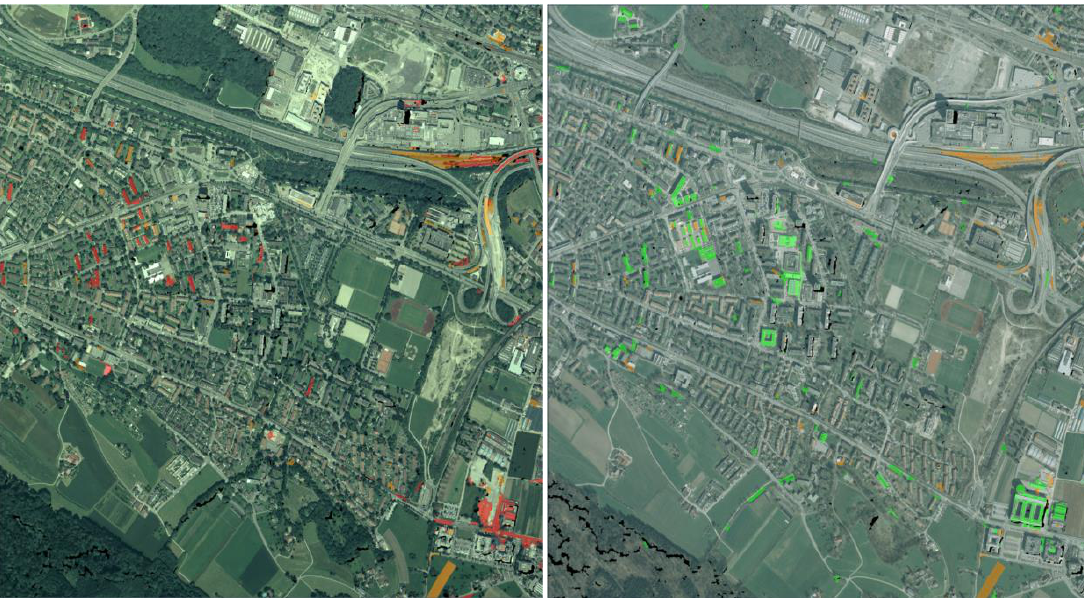
Figure 4. The result of a large area: Left: orthophoto in the year 2002; middle: orthophoto in the year 2007; (red: demolished: green: new building; orange: uncertain